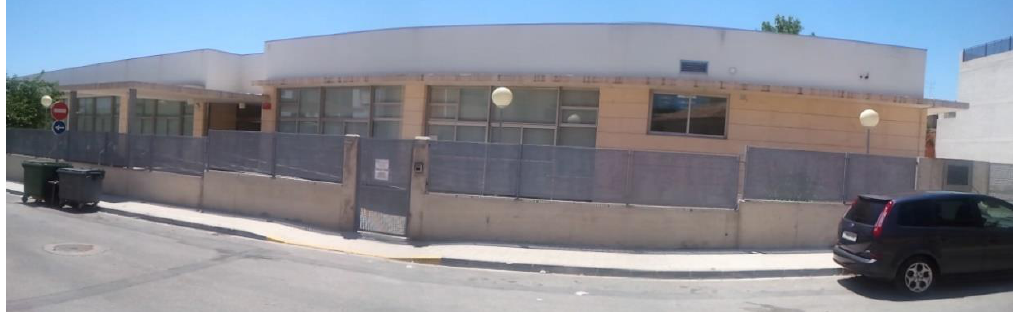
Figure 2. Building main facade (north).